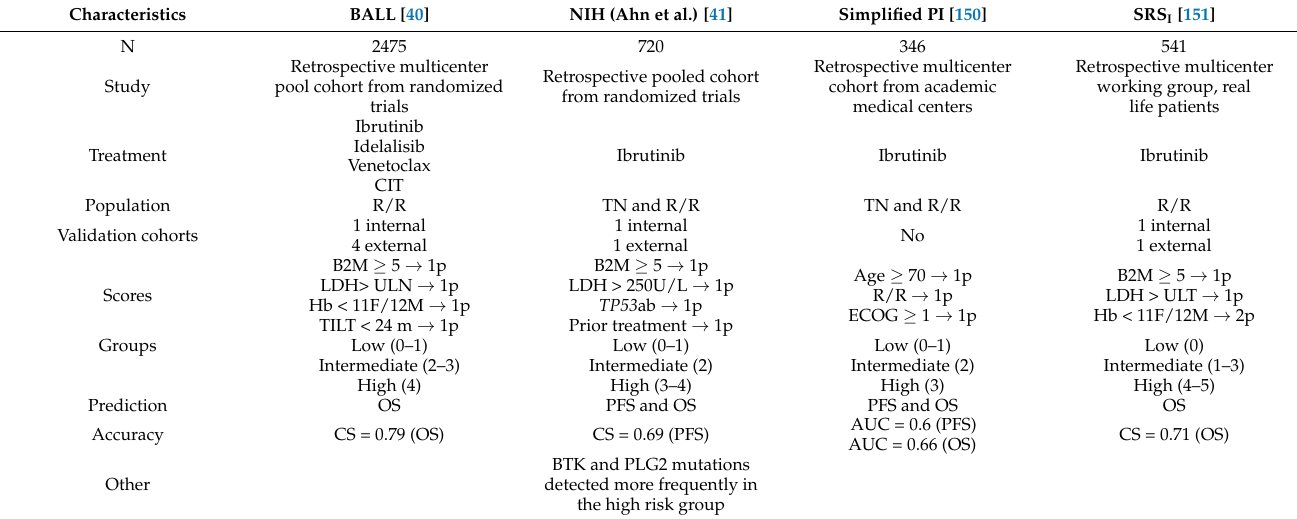
Table 3. Description of the published prognostic scores developed to predict outcomes for patients treated with targeted agents.